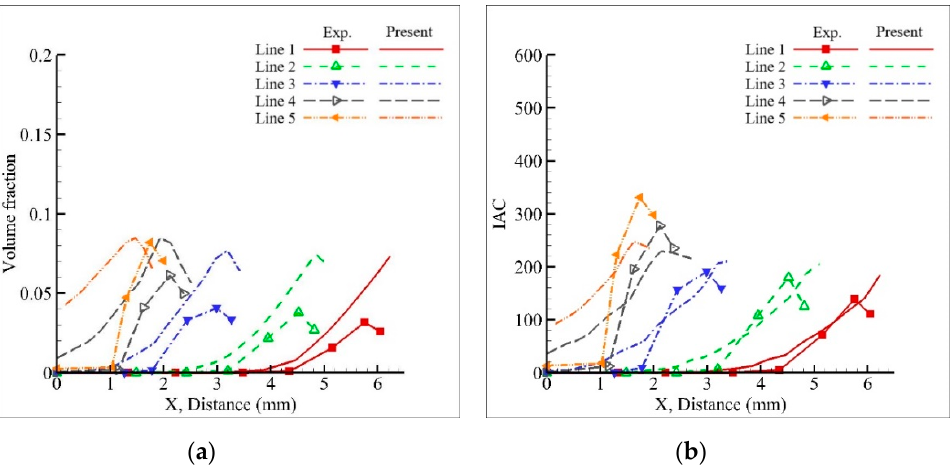
Figure 10. Case 4 numerical results of Lines 1–5 compared with experiment results: ( a ) volume fraction and ( b ) interfacial area concentration.